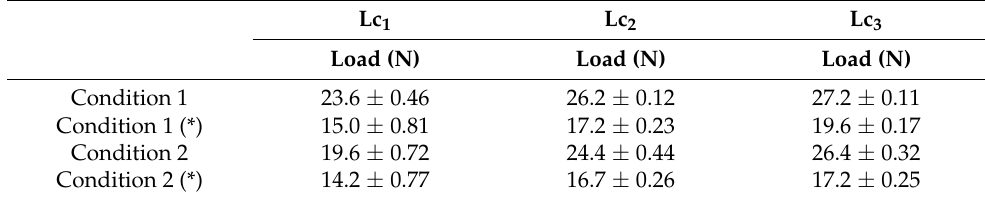
Table 6. Loads at critical failure for the coatings in conditions 1 and 2, before and after an HER test for 51 h.